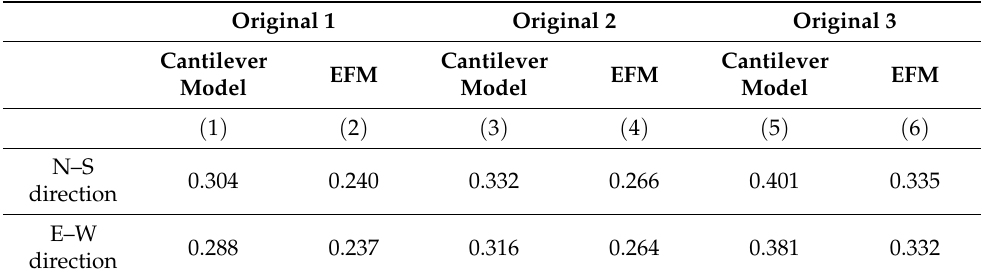
Table 2. Fundamental periods for the original structure.